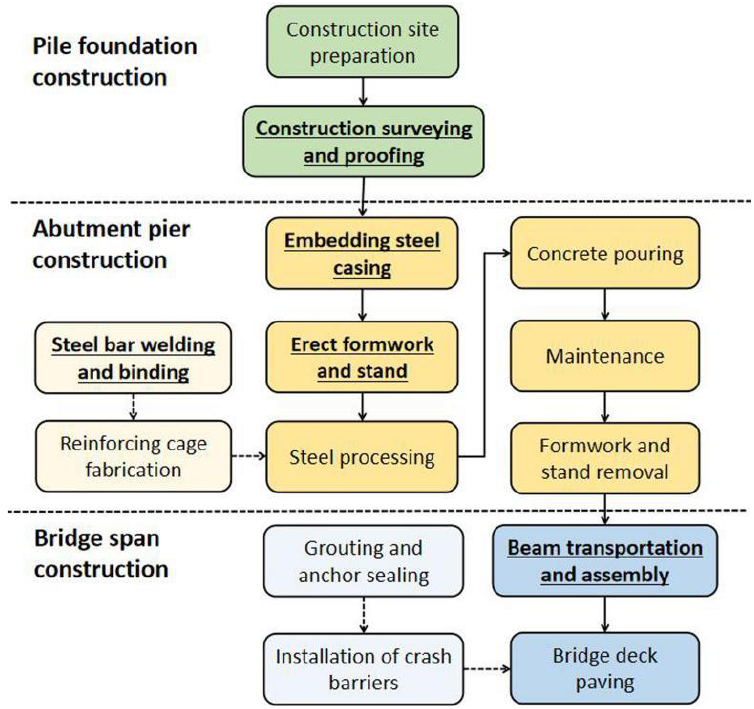
Figure 1. Schematic diagram of the bridge construction process.